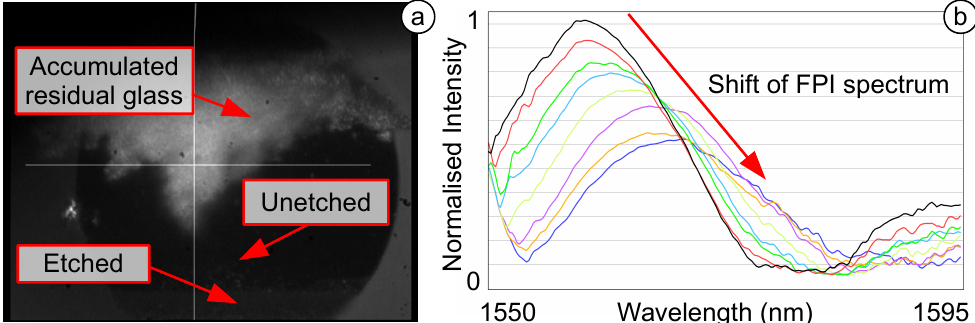
Figure 10. ( a ) Etching process by the FSL; ( b ) reflected FPI